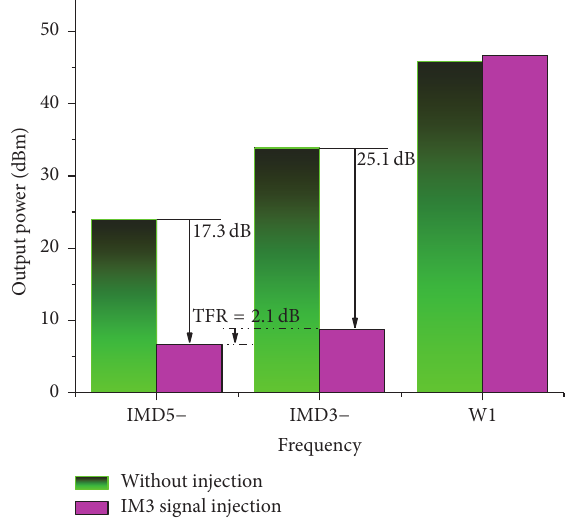
Figure 10: The output signal spectrum under optimal IMD3 − injection of simultaneous suppression for IMD3 and IMD5.